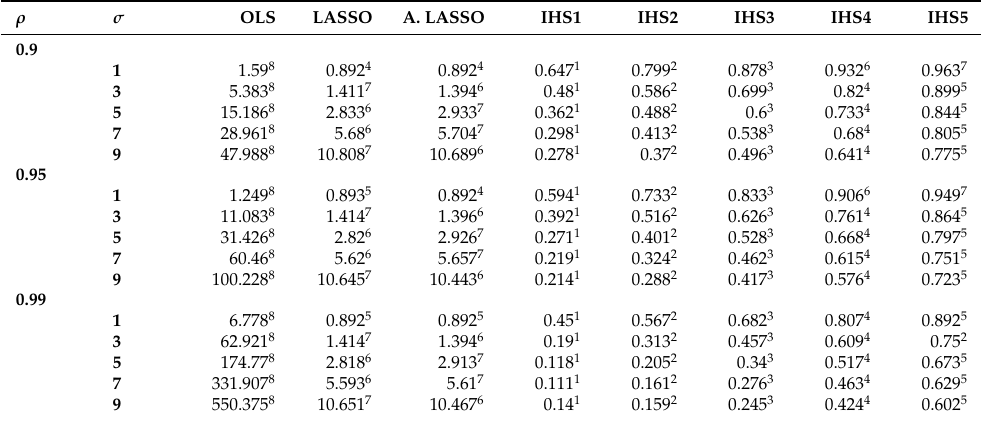
Table 5. Estimated MSEs for n = 100 and p = 8 (superscript represents ranking).